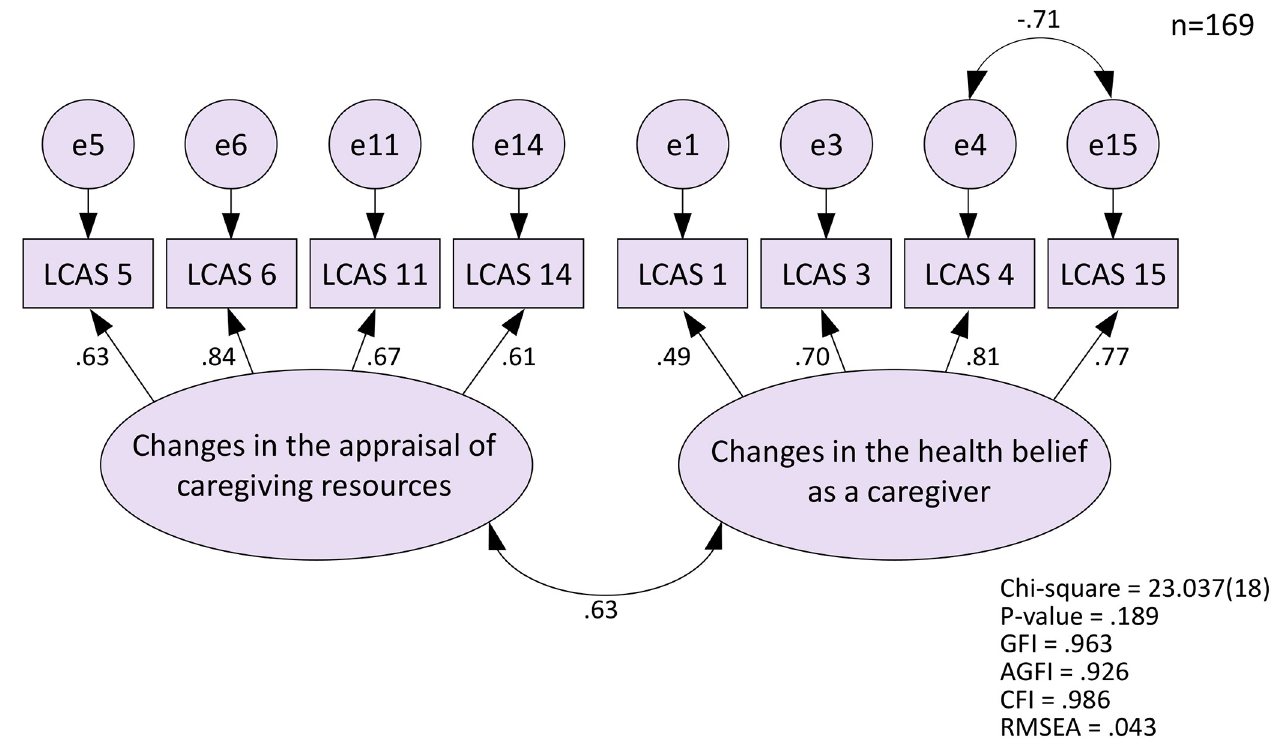
Fig 1. Confirmatory factor analysis of “the life change adaptation scale”.